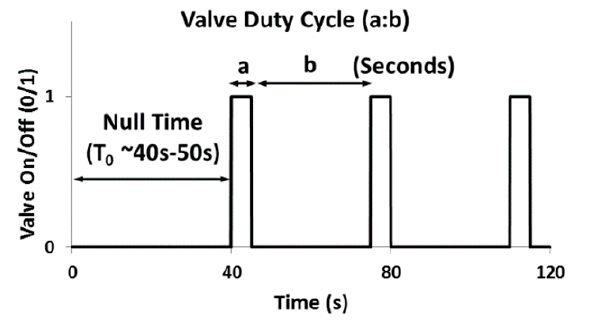
Figure 4. The valve duty cycle (a:b).